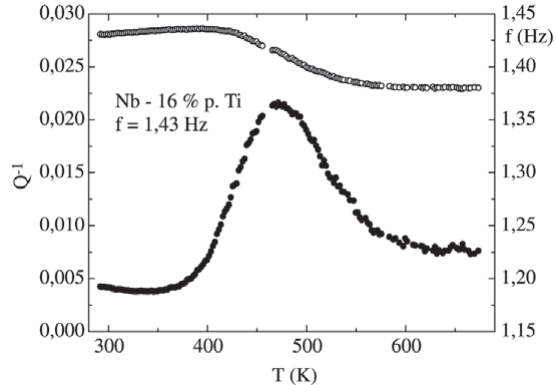
Figura 1. Atrito interno e freqüência em função da temperatura, para a amostra de Nb-16% p. Ti contendo oxigênio, medida com freqüência de 1,43 Hz.